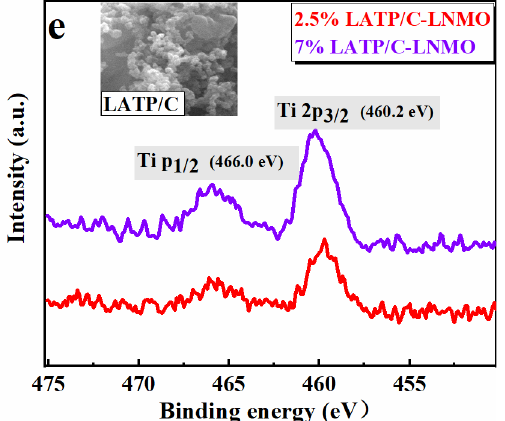
Figure 3. X-ray photoelectron spectroscopy collected at Mn2p and Ti2p regions of the bare LNMO and 2.5% LATP/C, 7% LATP/C coated composites and the SEM image of LATP/C. SEM analysis of different magnifications was carried out to observe the morphology and element distribution of the bare and LATP/C-coated LNMO. As shown in Figure 4b–d), apparent microspheres were observed on the surface of the coated composites compared with the smooth surfaces of the bare LNMO (Figure 4a), which illustrated that LATP/C adhered well to the surface of LNMO materials. Moreover, compared with bare LNMO particles (a typical octahedral shape), more contacted LATP/C- LNMO particles with round edges were observed with as the coating amounts grew. The rounded structure could be contributed by the coating of a LATP/C-doped lithium iodide film on the surface of the LNMO ball, and the protruded particles originated from the LATP/C complexes chimeric in the cladding layer.